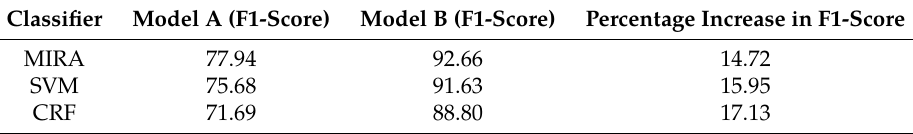
Table 13. Overall increase in F1-score after including gazetteer features.